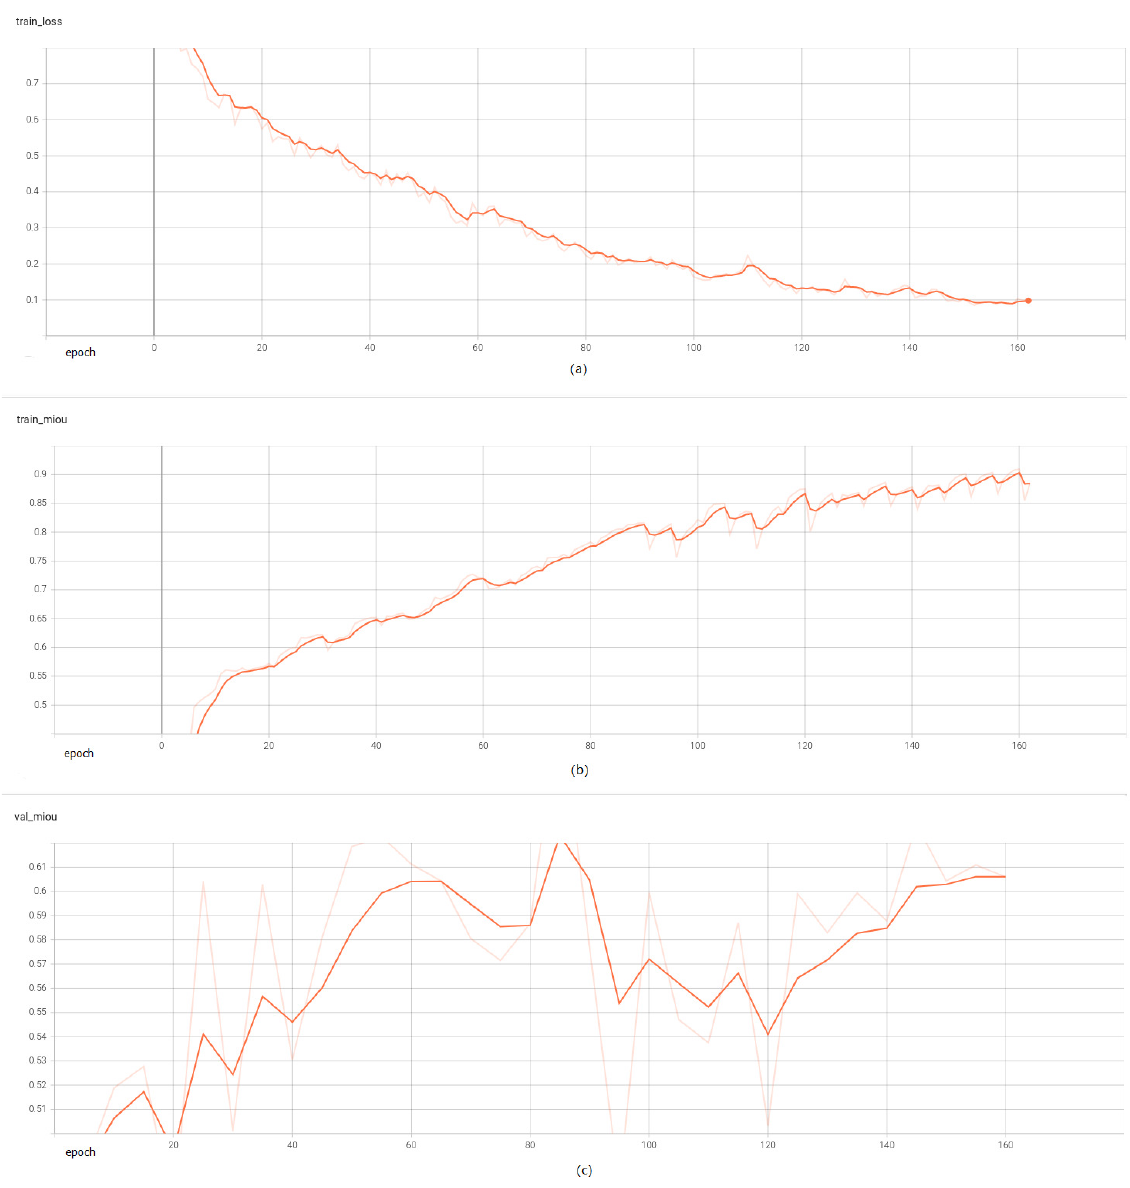
Figure 8. We use TensorBoard to draw the convergence curve of the training process, and the network has basically converged at 200 epochs. ( a ) train loss, ( b ) train MIoU, ( c ) val